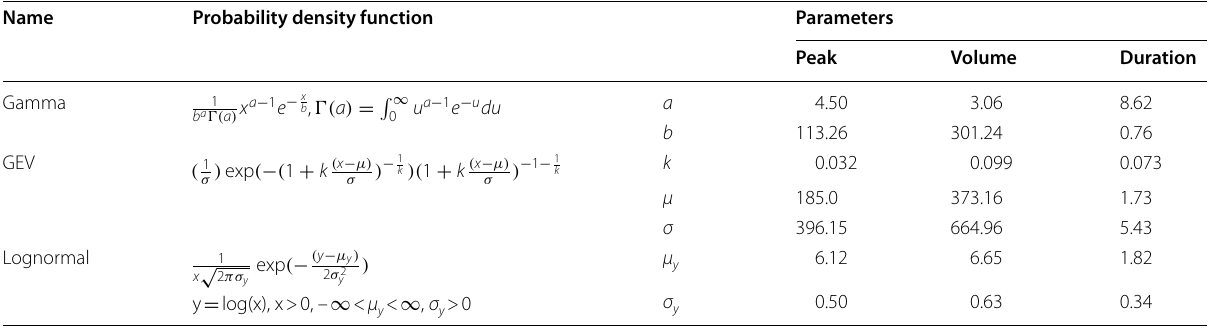
Table 3 Parameters of marginal distribution functions of flood variables